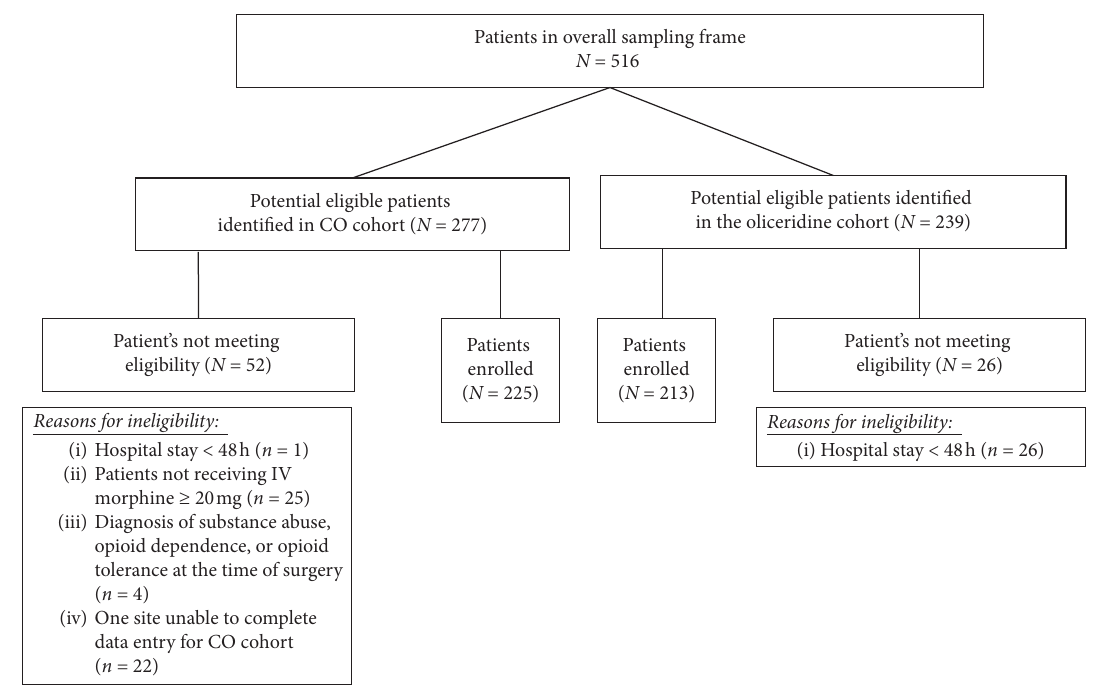
Figure 2: Patient disposition. Table 1: Demographic and baseline